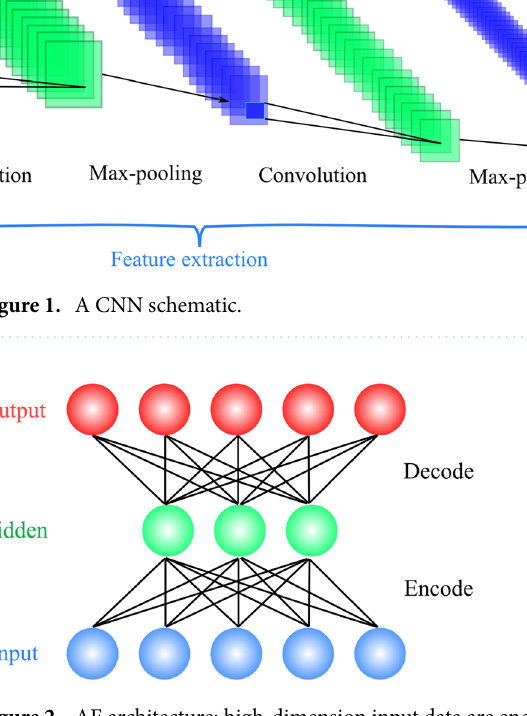
Figure 2. AE architecture: high-dimension input data are encoded (compressed) to form a latent (hidden) space that has a lower dimension than that of the original input. The latent representation is reconstructed (decoded) to yield decompressed